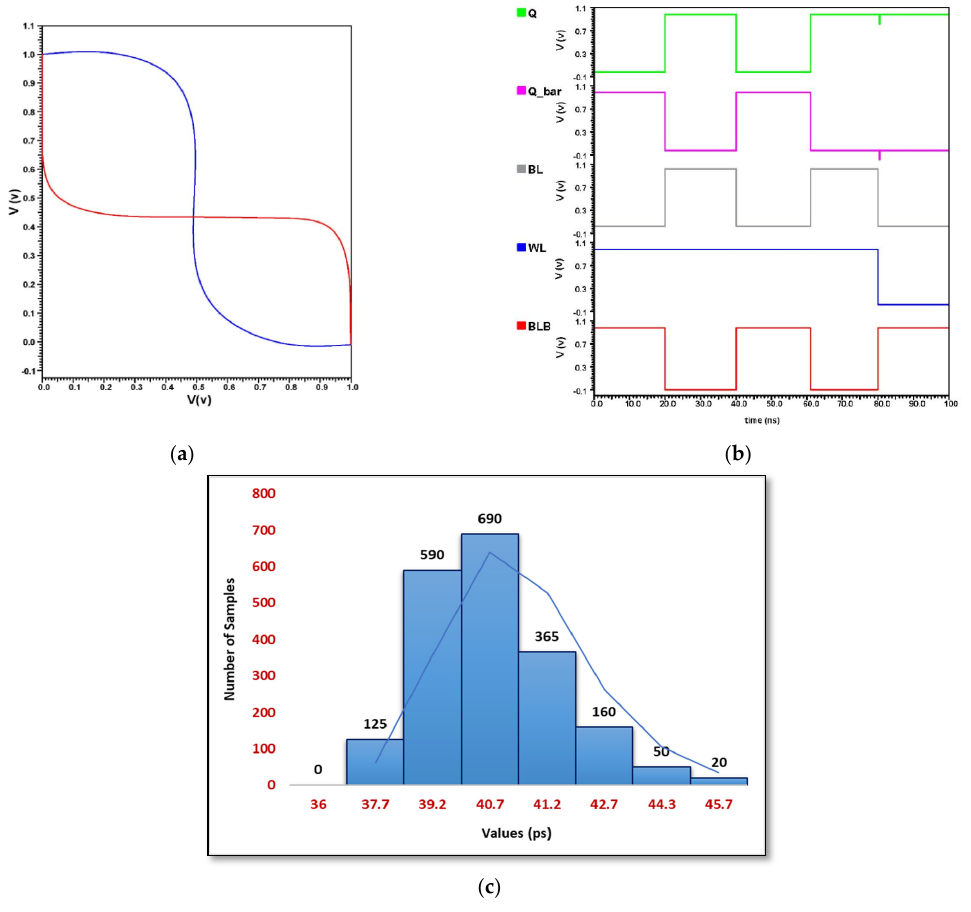
Figure 8. Conventional CMOS 6T ‐ SRAM, ( a ) DC Analysis, ( b ) Transient Analysis and ( c ) Monte Carlo Simulation